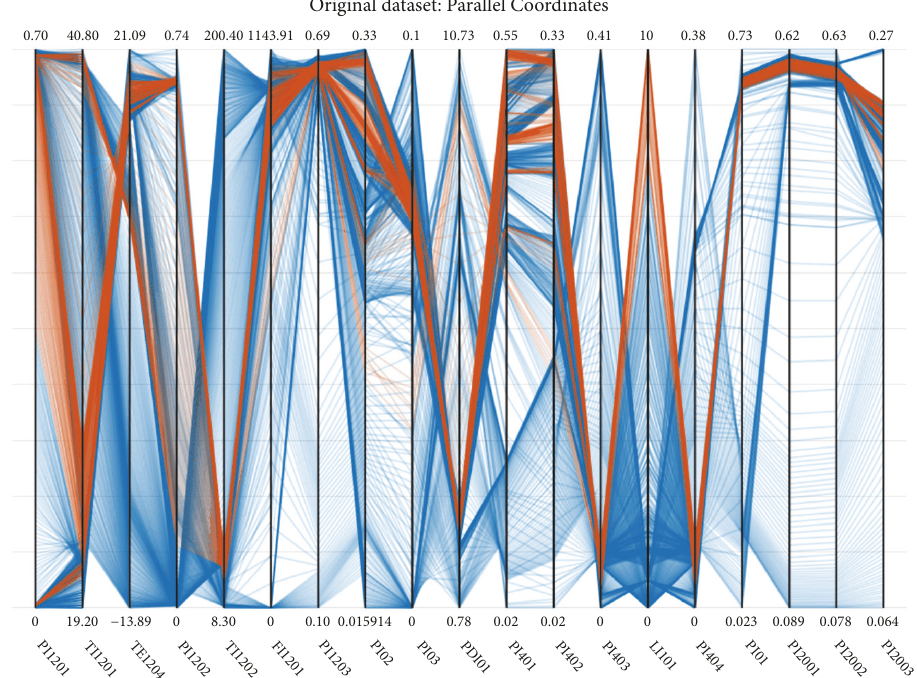
Figure 6: Visual correlation analysis local graph